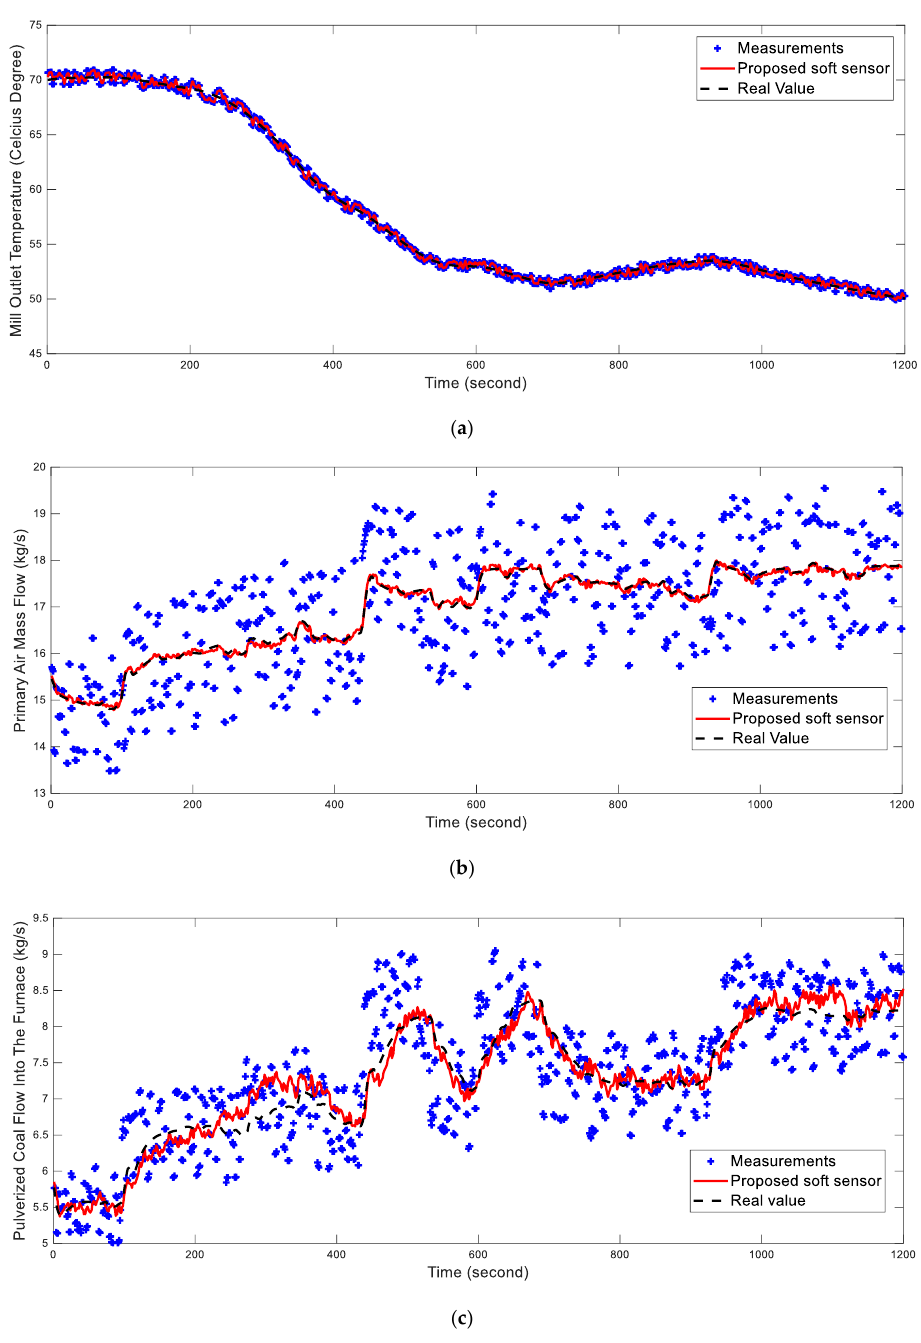
Figure 9. Estimates of ( a , b ) unmeasurable states and ( c , d ) raw coal parameters. ( a ) Raw coal stored in the mill; ( b ) Pulverized coal stored in the mill; ( c ) Moisture content; ( d ) Grindability.